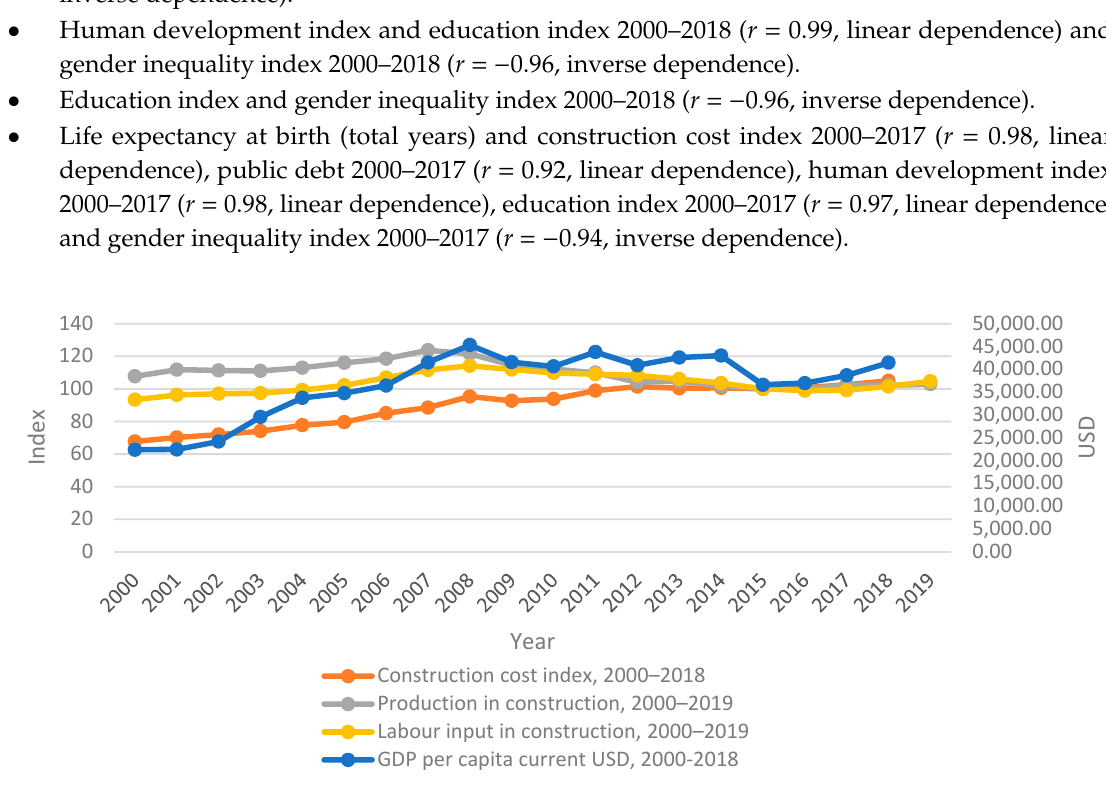
Figure 5. GDP per capita current USD, 2000–2018; construction cost index, 2000–2018; production in construction, 2000–2018; and labour input in construction, 2000–2018, data and their variation in France.